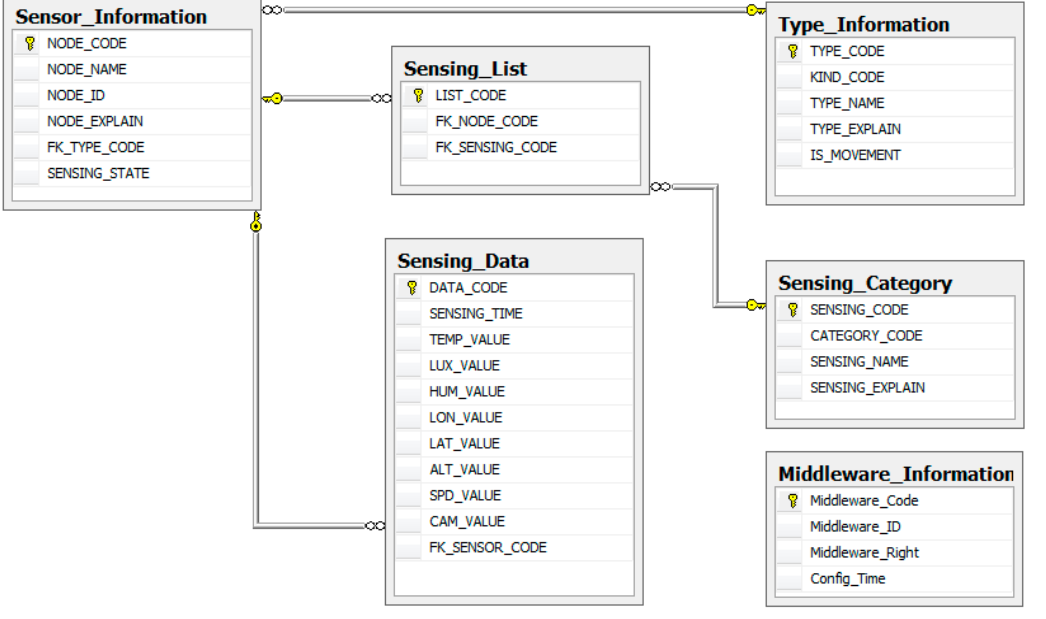
Figure 8. Sensor database relationship diagram .